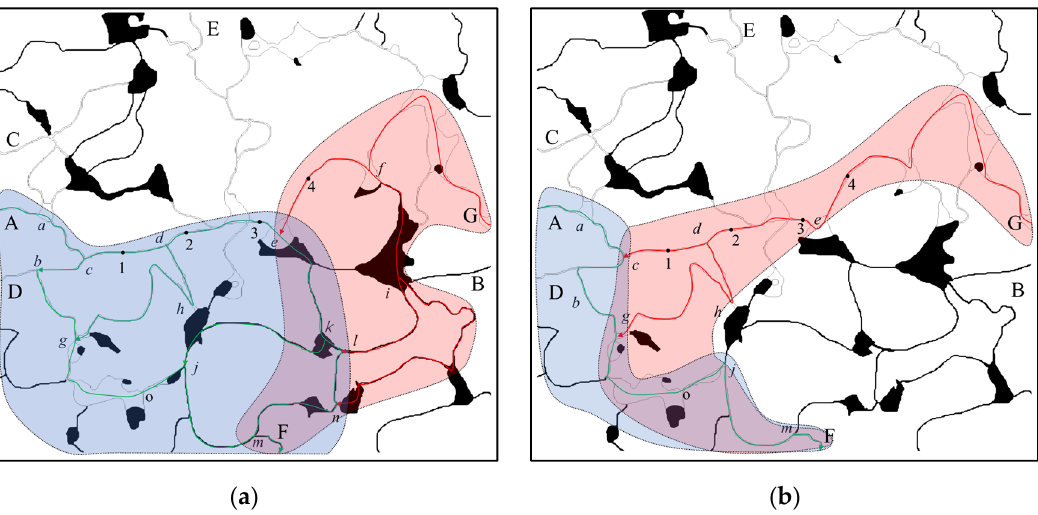
Figure 19. Flow paths and the residual oil distribution in different periods under simultaneous continuous injection conditions at port A and port G: ( a ) oil and water distribution during the pre-displacement, ( b ) final residual oil distribution.